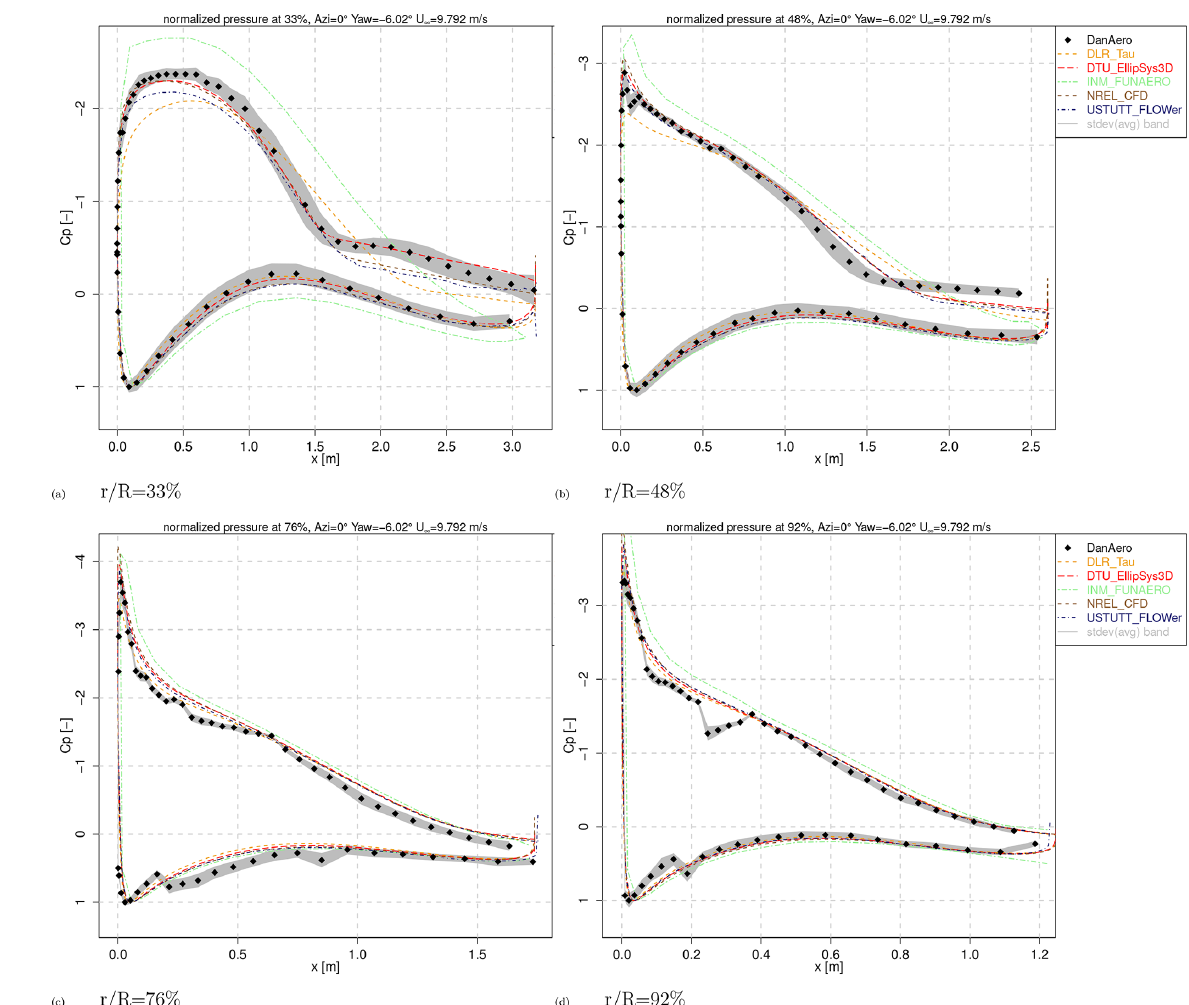
Figure 7. Pressure distribution comparison at 0 ◦ azimuth angle, Case IV.2.1. Animations of variation with an azimuth angle are available from the